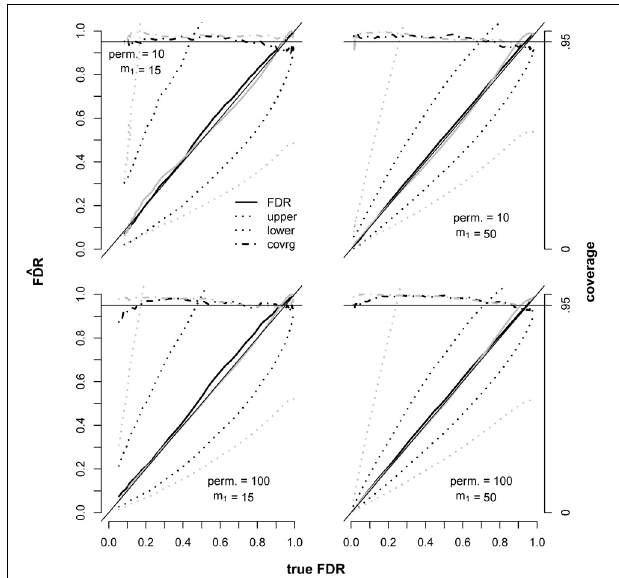
FIGURE 3 | Performance of the JM (black) and BE (gray) 95% CI estimators in the presence of dependent tests. Each plot represents 200 replicate datasets independently simulated under identical conditions. The true fdr ranged along the x-axis due to applying a variety of significance thresholds. Each dataset corresponded to 5050 tests. The number of false null hypotheses ( m 1 ) was fixed at either 15 or 50. The thin solid black line along the diagonal represents unbiasedness and the thicker solid lines denote FDR point estimates. Means for upper and lower 95 percent confidence bounds are shown as dotted lines. The target confidence interval coverage of.95 is displayed as a solid horizontal line at 0.95 and actual coverage by dashed lines. SNPs were generated in “LD blocks” with 5 SNPs per block and composite LD ranging from 0.4 to 0.9 within each block, and traits were generated in “modules” of correlated traits with 5 traits per module and correlations ranging from 0.4 to 0.9 within each module. Twenty LD blocks and 10 gene modules were included in each replicate